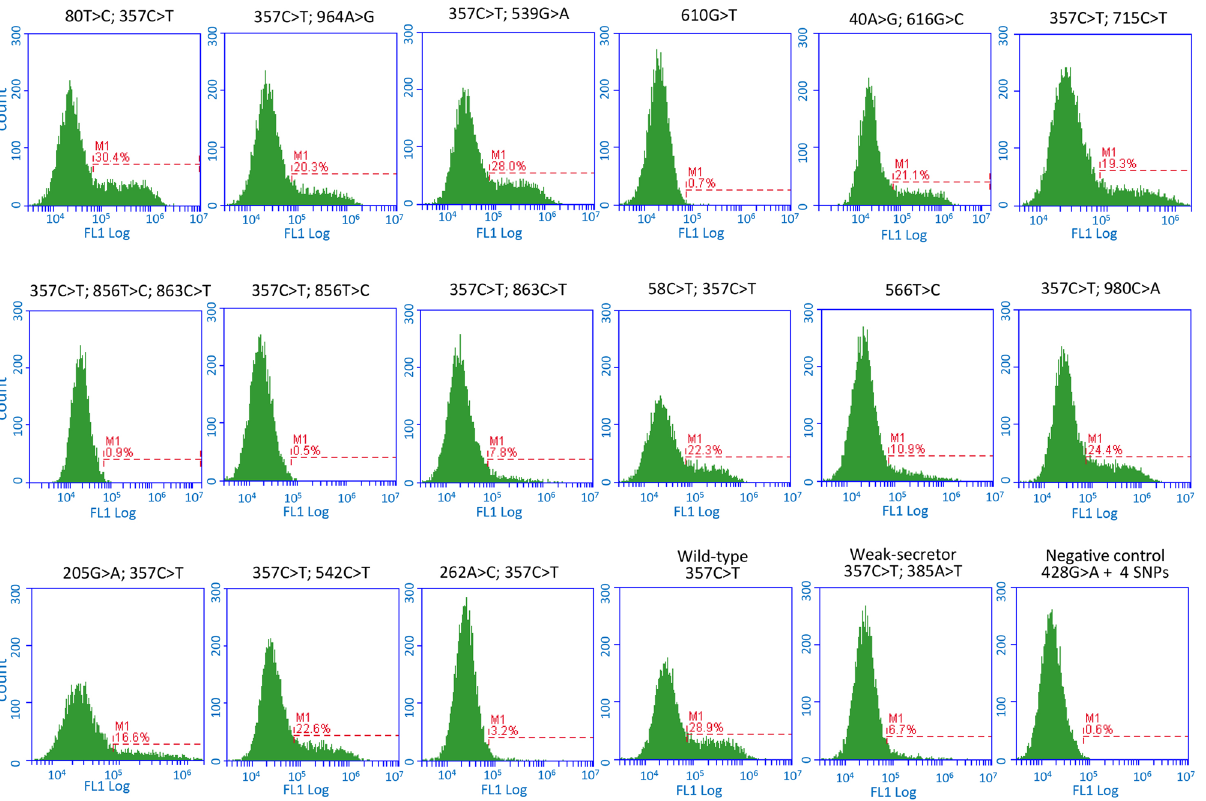
Figure 1. Expression of H antigens in the COS-7 cells transfected with various FUT2 constructs. The FUT2 allele containing uncharacterized SNP(s) of the FUT2 , Se 357 (wild-type allele), se 357,385 (weak-secretor allele), or se 428 (negative control) subcloned into pcDNA3.1(+) plasmids was transfected into COS-7 cells. After 2 days of culture, the cells were incubated with 1E3 antibody, followed by incubation with FITC-conjugated goat anti-mouse IgM secondary antibody, and expression of H antigen on the cell surface was monitored by flow